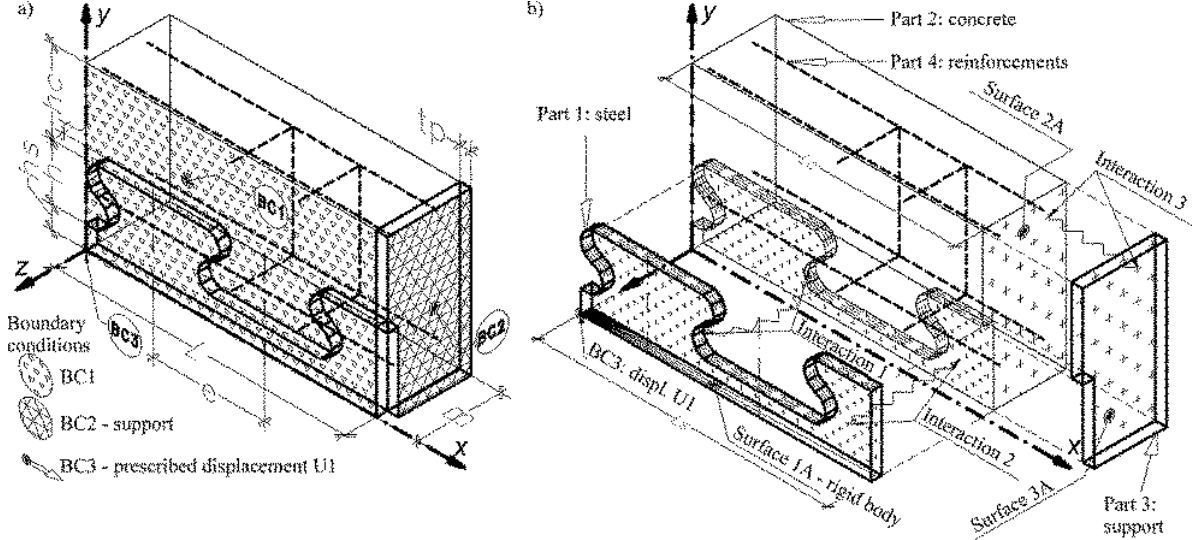
Figure 13: Assumptions for the 1D1 model used for the purposes of